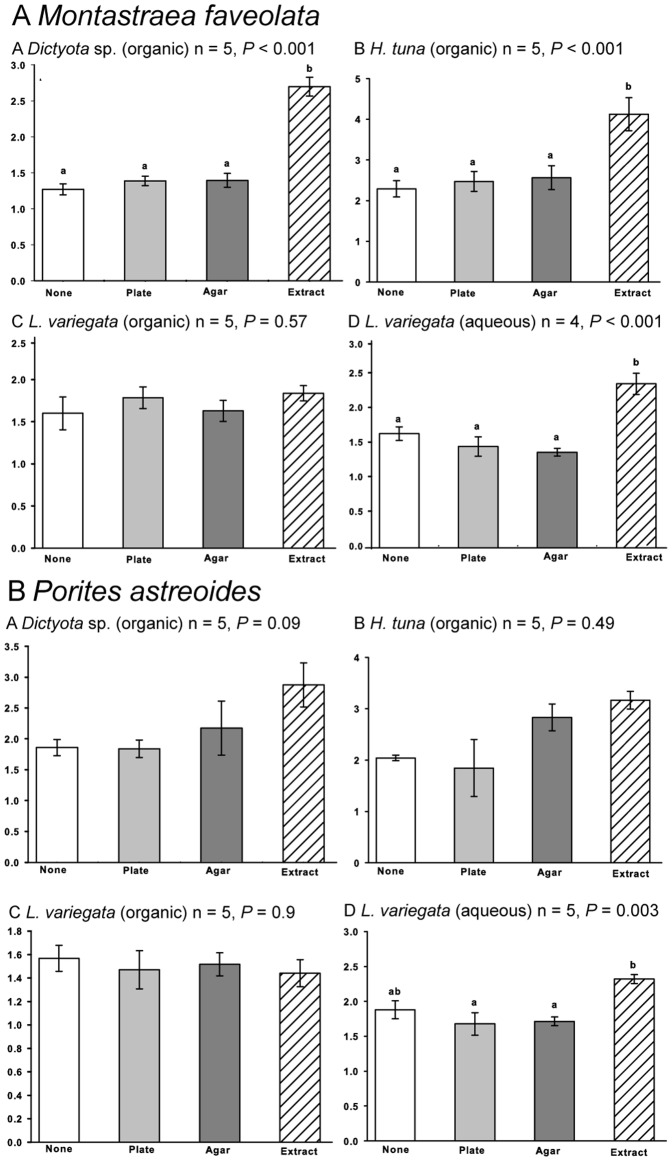
GST activity for corals exposed to extracts.Glutathione S-transferase (GST) activity of A. M. faveolata and B. P. astreoides corals exposed to macroalgal extracts following a 72 h exposure period: Application of A. Dictyota sp. organic extract, B. Halimeda tuna organic extract, C. Lobophora variegata organic extract, D. Lobophora variegata aqueous extract for each coral species. GST activity is expressed in nmol min−1 mg protein −1.